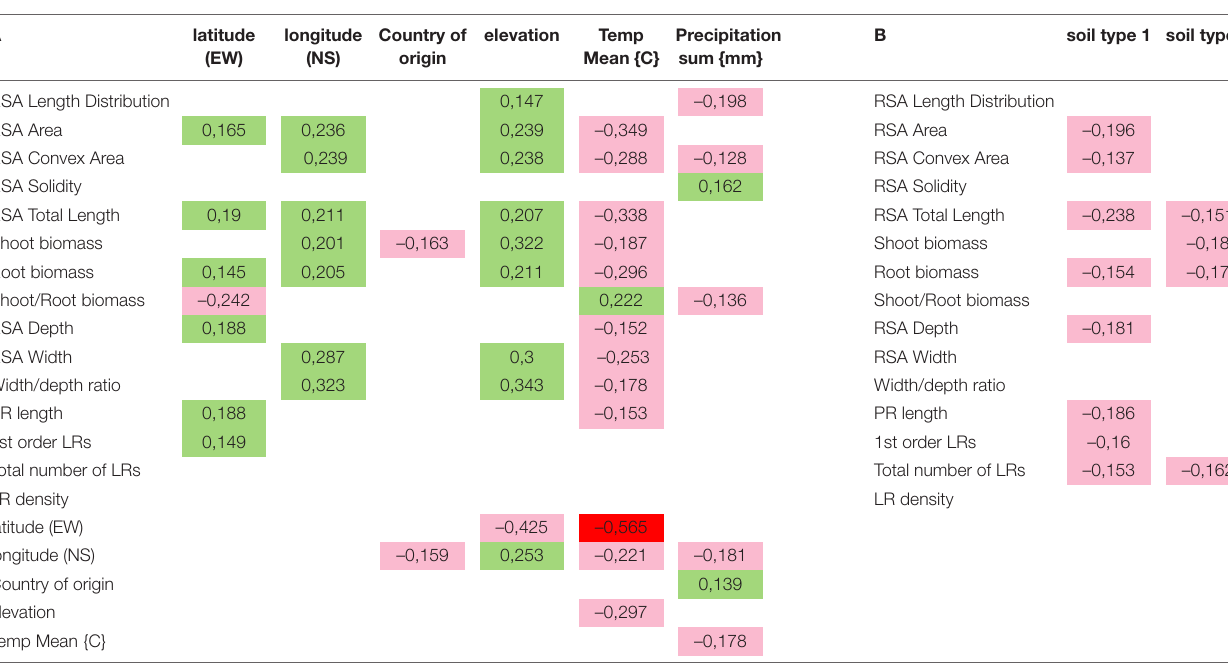
TABLE 3 | Correlation analysis between 15 RSA traits and: A - geographical/climate features of their place of origin, B – soil types depending on the soil taxonomy (for the description of soil types, please refer to the Supplementary Table 4